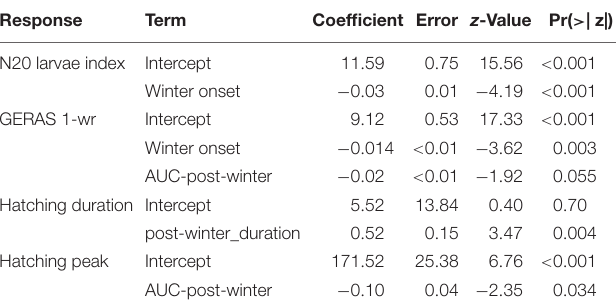
TABLE 2 | Summary of terms from the best candidate models for the N20 larvae index, GERAS 1-wr index, hatching duration, and hatching peak.